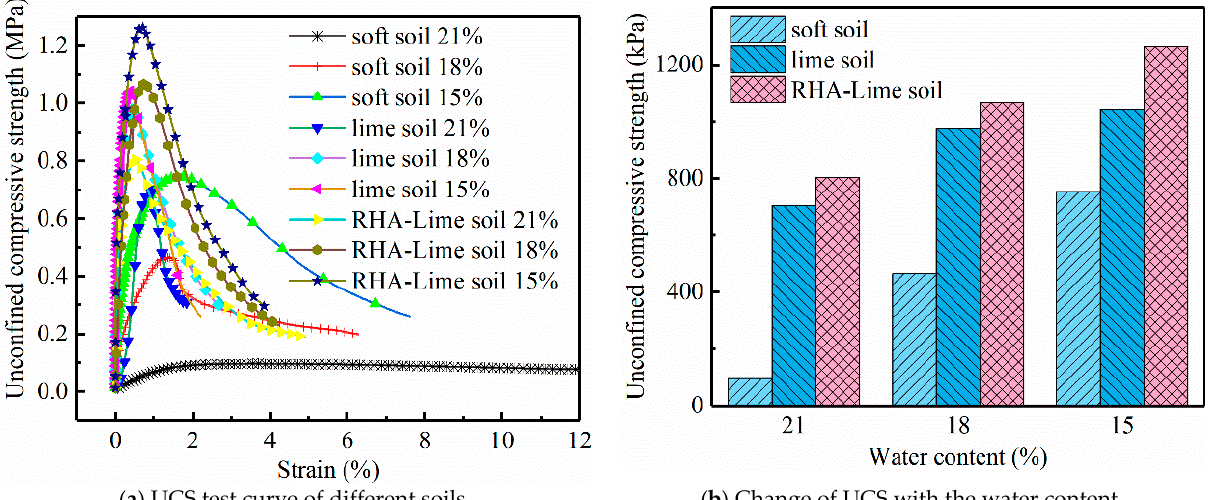
Figure 7. Unconfined compressive strength test